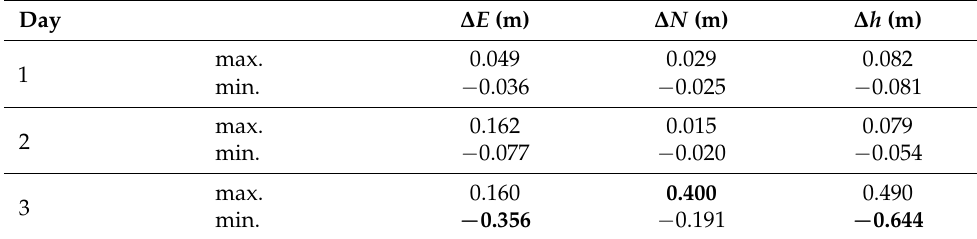
Table 1. Characteristic deviation of the GNSS coordinates from their mean values per measure- ment’s